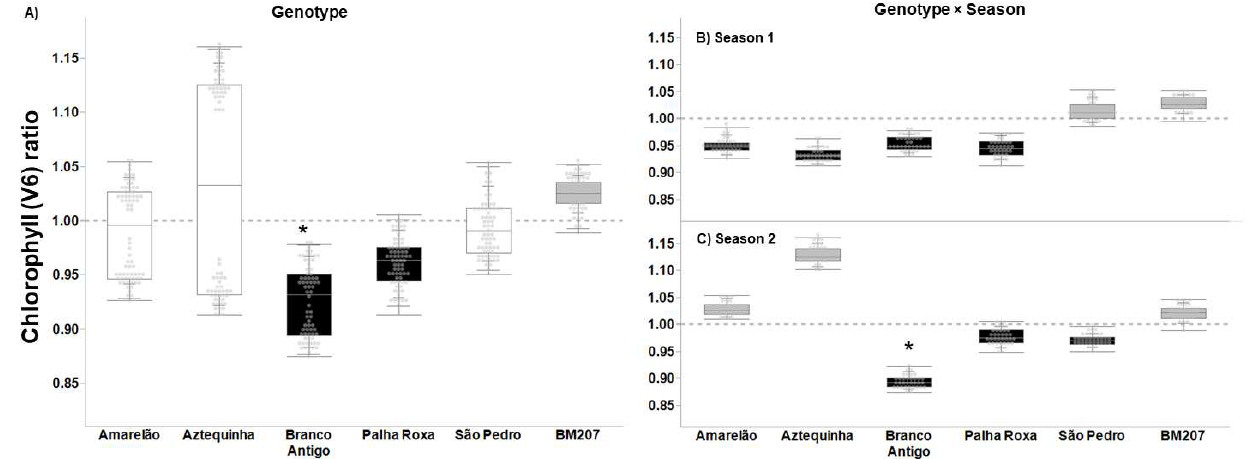
Figure 3. Tolerance ratio to FAW (= plant without insecticide application/average of plants with insecticide application) based on the parameter chlorophyll content at V6 stage in six maize genotypes ( A ), six genotypes in season 1 ( B ), and six genotypes in season 2 ( C ). In each plot, asterisks indicate statistical difference relative to BM207, per Dunnett’s test ( A ), and per a priori contrasts ( B , C ) with critical p ≤ 0.010 per Sidak’s correction. In each plot, black-filled boxes indicate non-tolerance (undercompensation, ratio < 1), gray-filled (overcompensation, ratio > 1) and white-filled (compensation, ratio = 1) boxes indicate tolerance (critical p = 0.014 per Bonferroni correction). The landrace Palha Roxa overcompensated for the chlorophyll content during the reproductive stage (Figure 4A, ratio = 1.25, F = 79.743, p < 0.0001) and showed a higher tolerance ratio than hybrid BM207 (Figure 4a, p < 0.0001). The genotypes Aztequinha and São Pedro were tolerant through compensation ( p = 0.032) and overcompensation ( p < 0.0001), respectively (Figure 4A). In the genotype × season interaction, Palha Roxa was the only genotype to show overcompensation in both seasons (Figure 4B,C, p < 0.0001). Ama- relão, Aztequinha, and Branco Antigo were lower than BM207 in season 1 (Figure 4B, p = 0.0001), while Aztequinha and Palha Roxa were superior to BM207 in season 2 (Figure 4C, p ≤ 0.002).